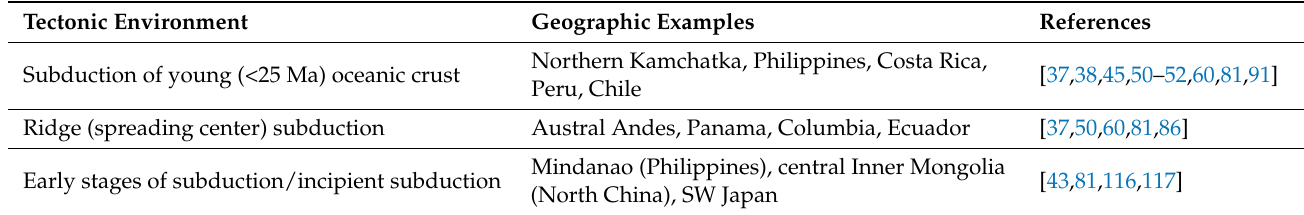
Table 2. Tectonic environments of adakite